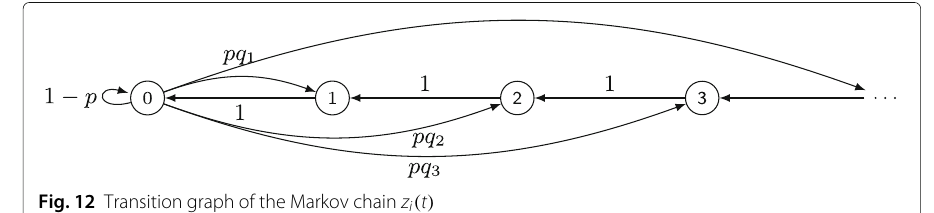
Fig. 12 Transition graph of the Markov chain z i ( t